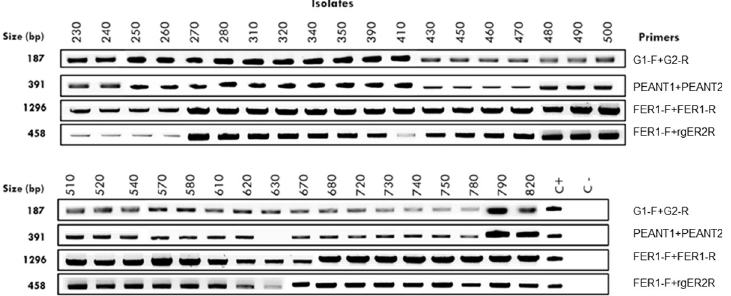
Fig 1. Identification of Erwinia amylovora Portuguese isolates by PCR, using specific primer pairs, according to EPPO protocol [59]. Bacterial isolates are identified by strain numbers on the top. Primers used are listed on the right, and DNA product sizes in bp are indicated on the left. Positive control (C+): Type Strain LMG 2024. Negative control (C-): H 2